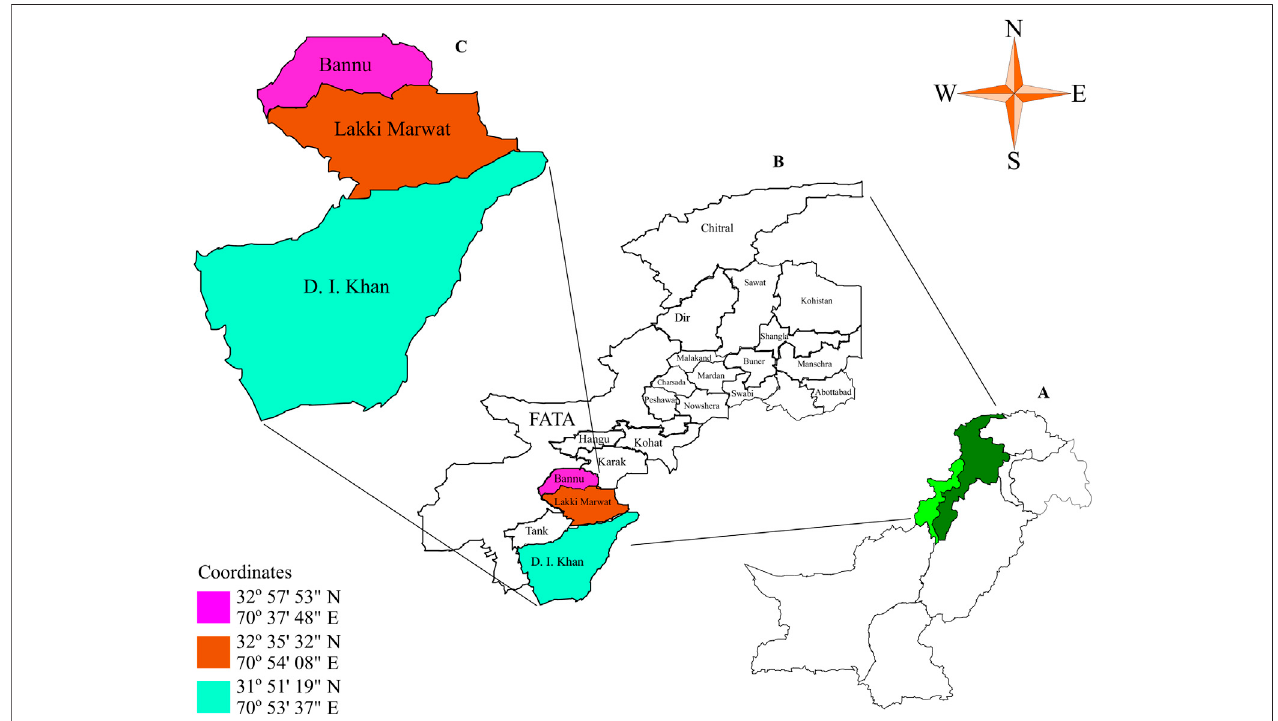
FIGURE 1 | Map of the study area (A) Pakistan (B) Khyber Pakhtunkhwa (C) selectiive districts in southern Khyber Pakhtunkhwa.